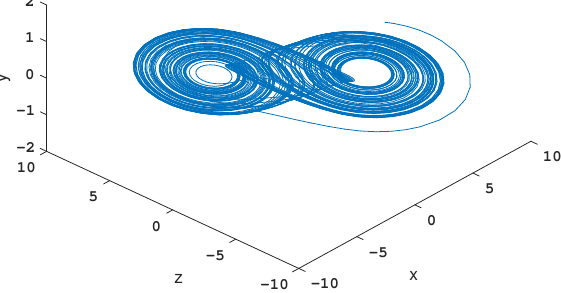
Figure 4. The chaos diagram of Chua’s system at initial condition x 0 = [ 5,1, − 3 ] T .